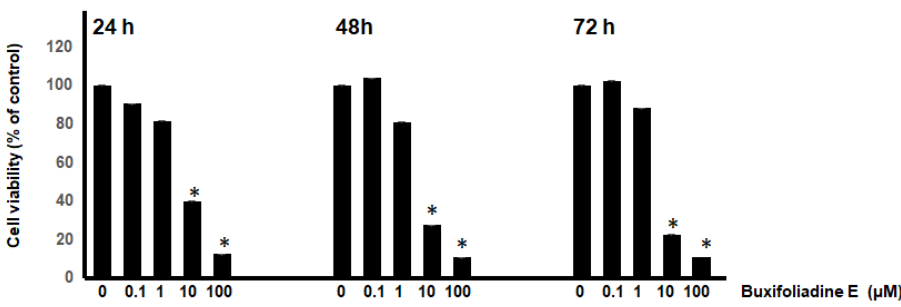
Figure 3. Dose-response and time-course experiment. LNCaP cells were treated with various con- centrations of buxifoliadine E for 24 h, 48 h, and 72 h. * p < 0.05.